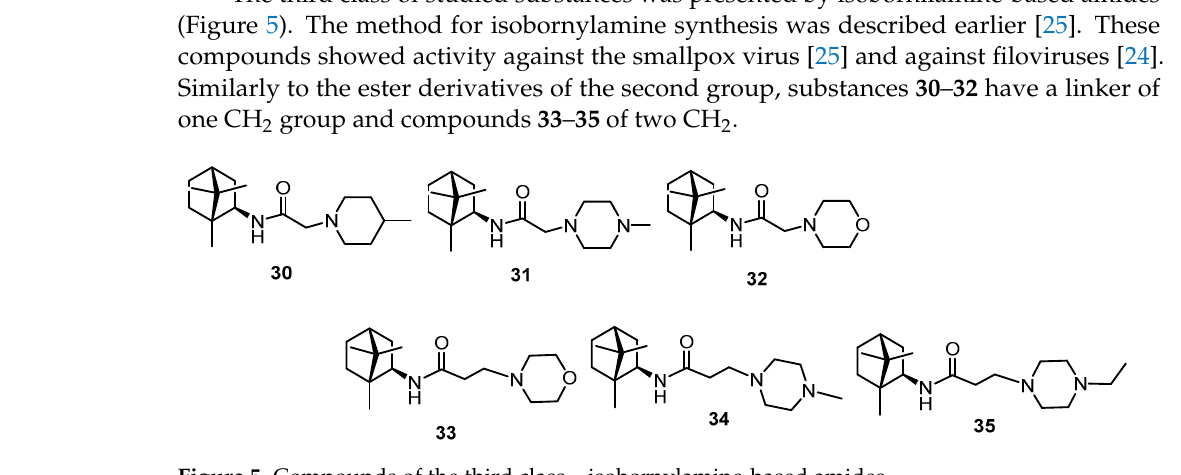
Figure 5. Compounds of the third class—isobornylamine-based amides.